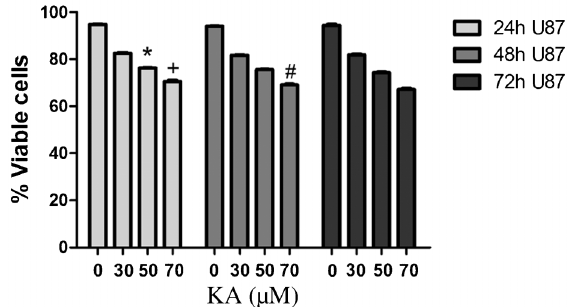
Figure 2. Effect of kaurenoic acid (KA) treatment on cell viability. U87 cells were treated with different concentrations of KA, and the trypan blue dye-exclusion method was used to detect cell viability. The y-axis shows the percentage of cell viability. The concentrations of KA used and the durations of the treatments are indicated. Data are reported as means ± SD of 3 determinations. *P , 0.05 for 50 m M KA: 24 compared to 72 h; + P , 0.05 for 70 m M KA: 24 compared to 48 and 72 h; # P , 0.05 for 70 m M KA: 48 compared to 72 h (Bonferroni multiple comparison test).